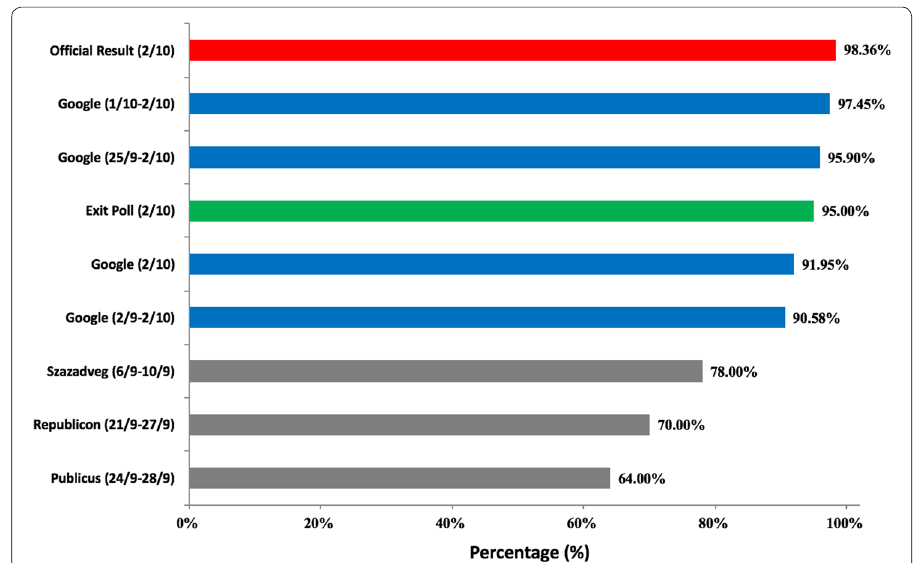
Fig. 5 Comparisons of the official Hungarian Referendum results with Google Trends, poll agencies, and the exit